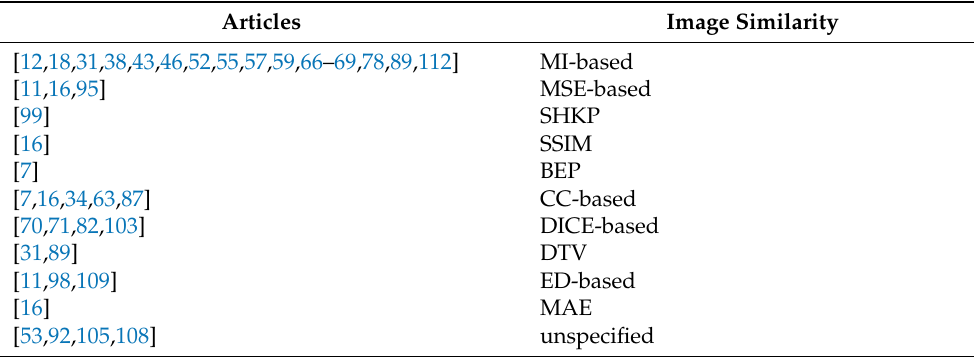
Table 3. Similarity indicators used in the reviewed articles.